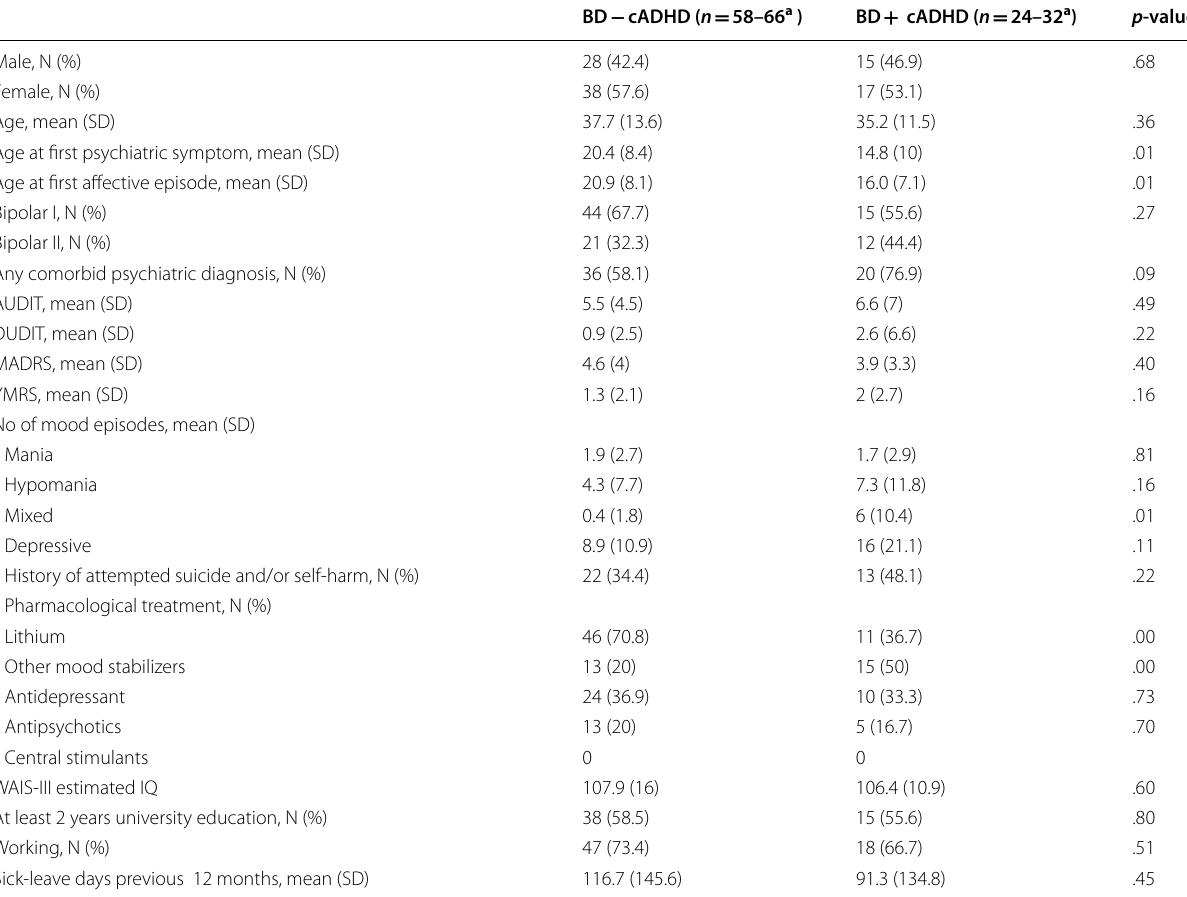
Table 1 Clinical characteristics of the bipolar disorder group without childhood ADHD (BD disorder group with childhood ADHD (BD